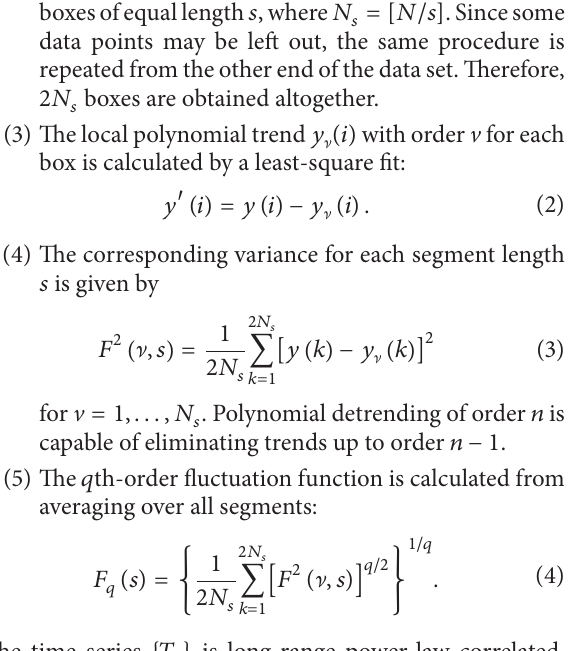
Table 1: Coordinates of the daily AGST sites.